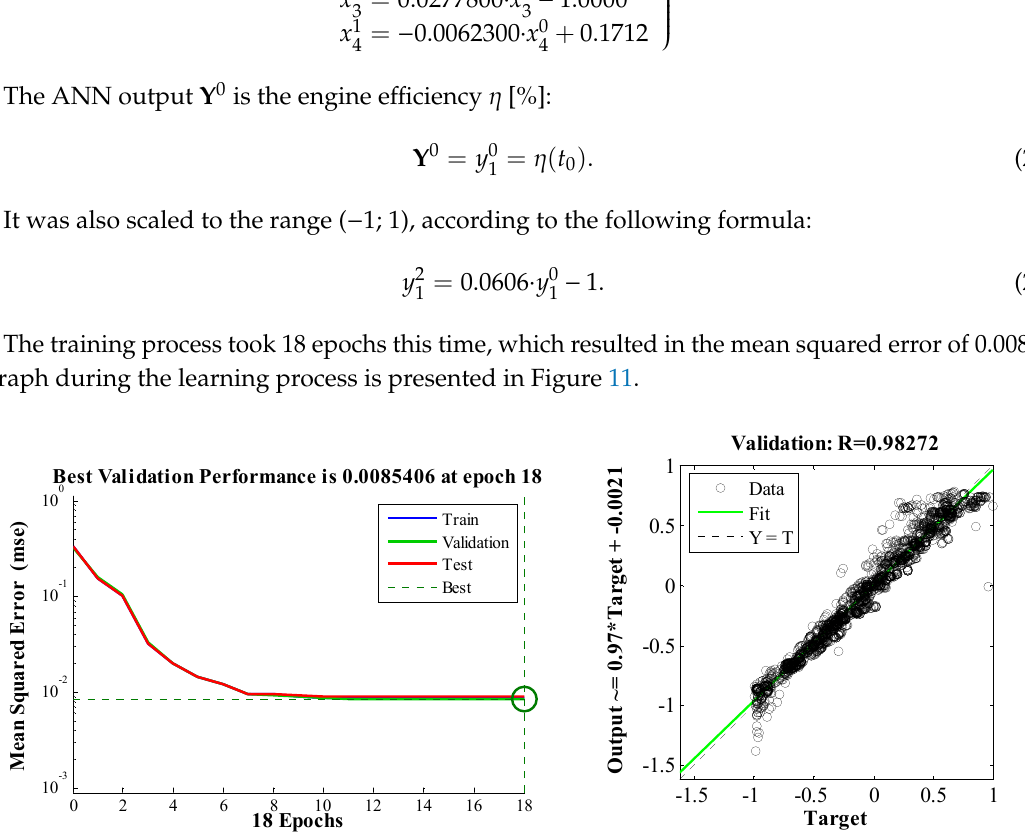
Figure 11. Mean squared error vs training epochs and regression plot.